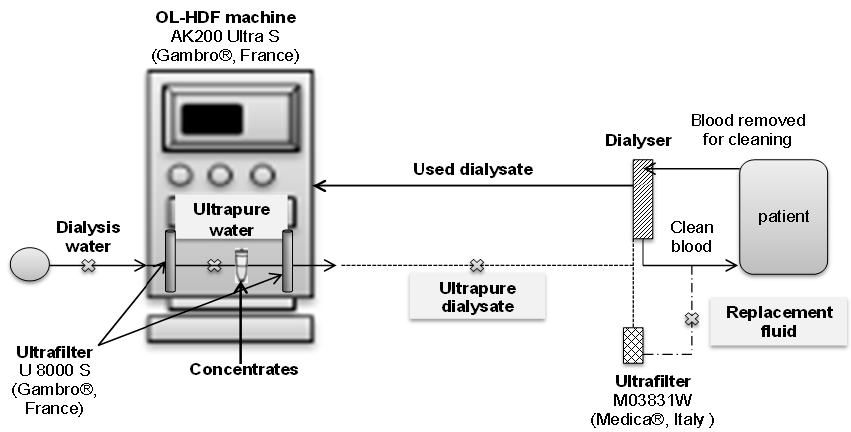
Figure 2. Sample location ( : SP) for ultrapure water, ultrapure dialysate and replacement